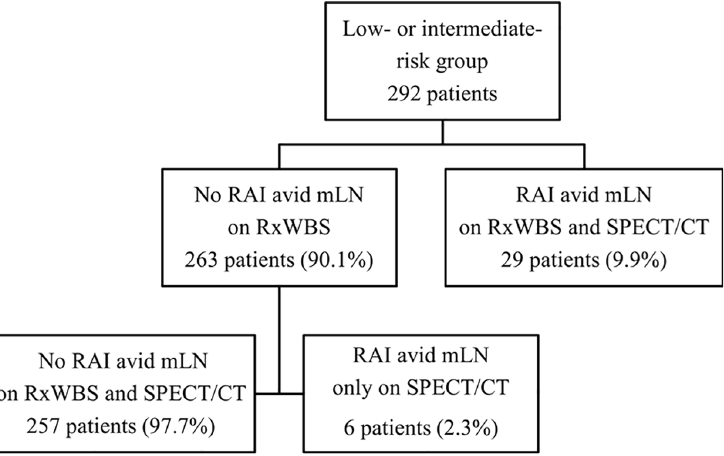
Fig 1. Result of postablation I-131 whole-body scintigraphy and postablation SPECT/CT in the low-or intermediate-risk group. SPECT/CT: single-photon emission computed tomography; RAI: radioactive iodine; mLN: metastatic lymph node; RxWBS: postablation I-131 whole-body planar scintigraphy.